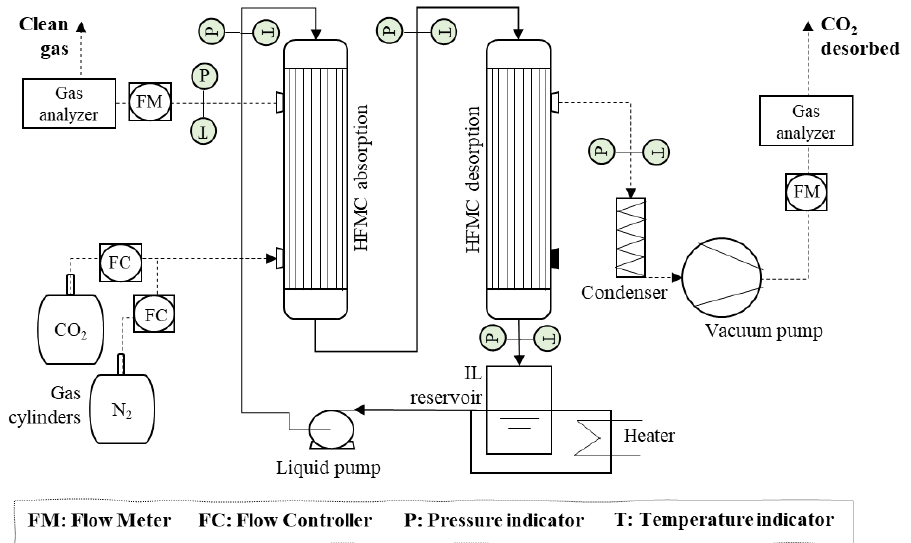
Figure 2. Experimental set-up of continuous absorption – desorption process using MVR technol- ogy.